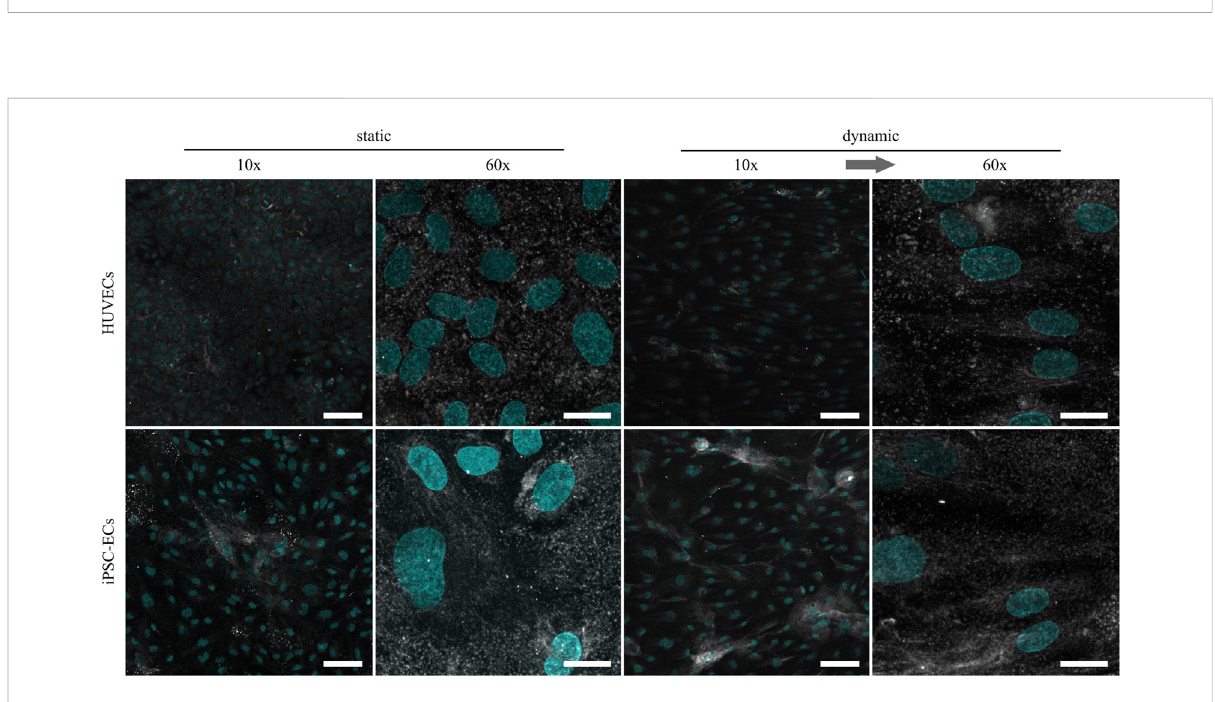
FIGURE 4 Representative confocal immuno fl uorescence images of a hyaluronic acid staining (grey) of HUVECs and iPSC-ECs after 96 h of static and dynamic culture. Nuclei were counterstained with Hoechst 33342 (cyan). (Arrow indicates fl ow direction. Scale bars: 10× 100 µm, 60× 20 µm).